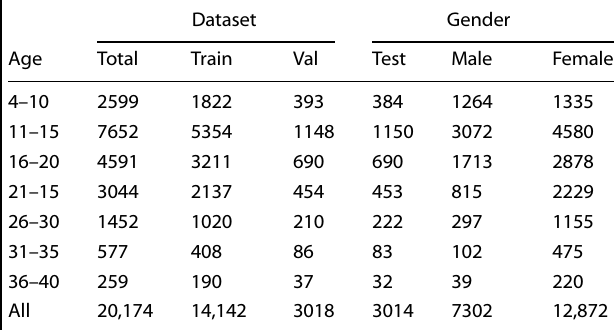
Table 3. The age distribution of the LCR